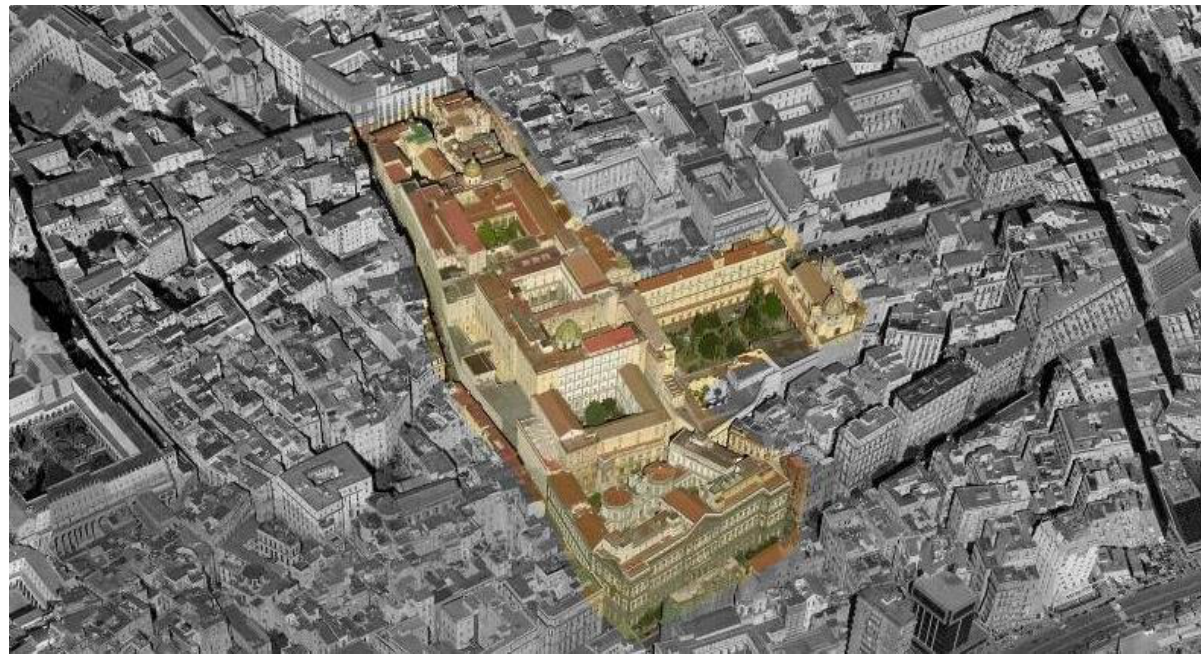
Figure 1. The Federico II settlement in the historic center of Naples. The aggregate of Mezzocannone with the front building built by Guglielmo Melisurgo and Pierpaolo Quaglia between the end of the nineteenth century and the beginning of the twentieth